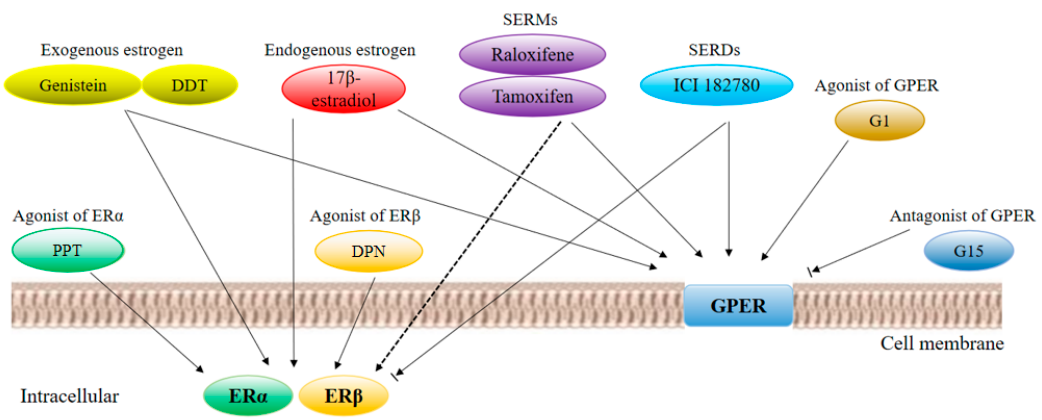
Figure 1. G-protein-coupled estrogen receptor (GPER) and agonists and antagonists of cell-membrane-bound receptors derived from estrogen receptor (ER) α and ER β , involved in rapid intracellular signal transduction. Arrows indicate activation, blocked arrows indicate inhibition, and dashed lines indicate tissue-specific activation or